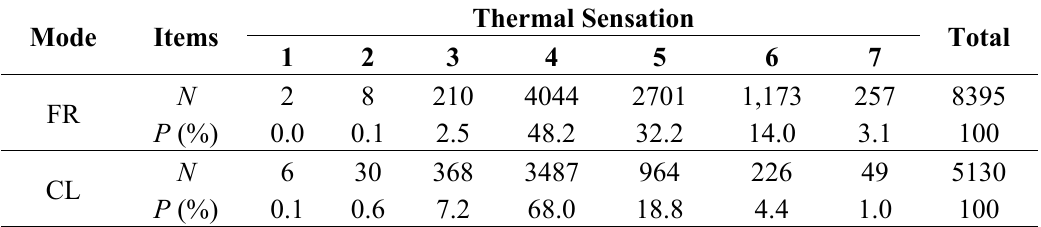
Table 6. Percentage of thermal sensation on the SHASE scale in FR and CL modes.